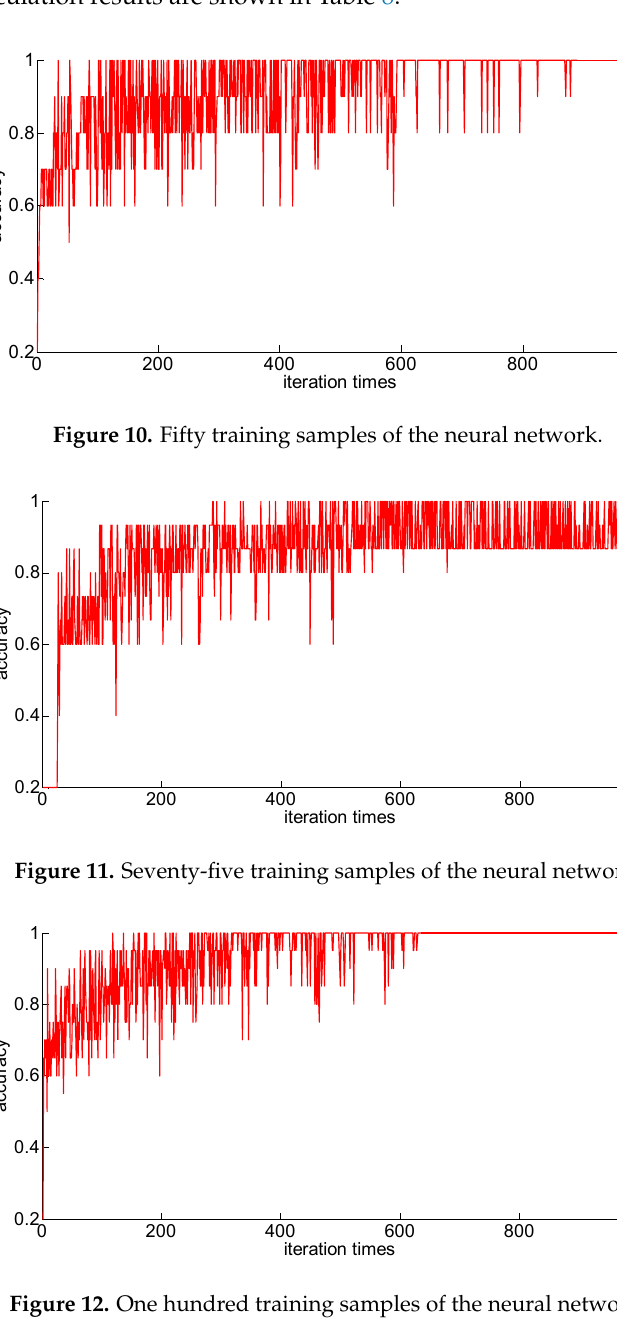
Figure 13. One hundred twenty-five training samples of the neural network.